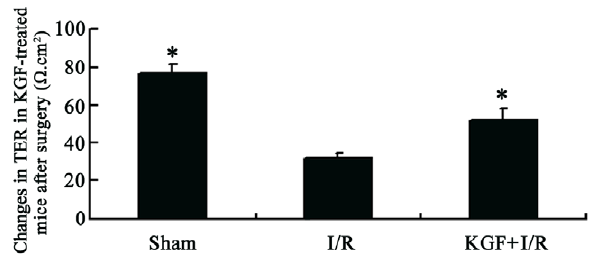
Figure 8. Changes in TER of I/R mice after KGF treatment. The permeability of the small intestine was evaluated by TER. Tissues were harvested at 6 h after intestinal I/R, * P , 0.05 vs. I/R group, n=6 per group.